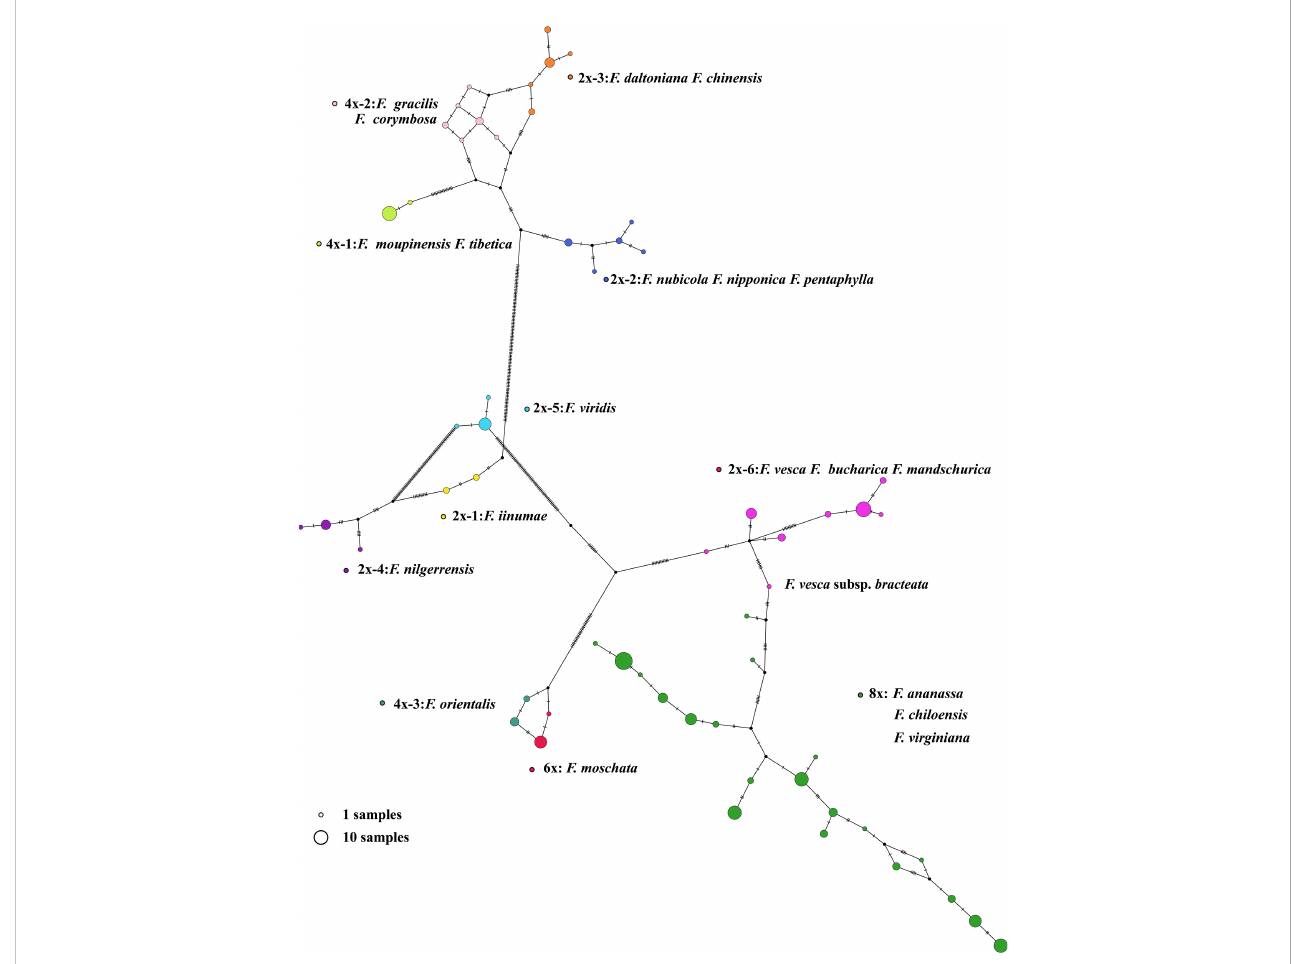
FIGURE 4 The chloroplast haplotypes network of Fragaria species. The size of the circle represents the number of haplotypes. Dots represent putative haplotypes. Mutations are represented by perpendicular dashes. The red arrow indicates the diploid F . vesca subsp.